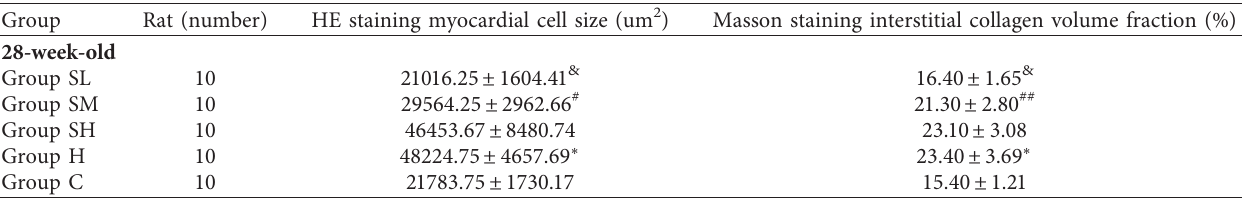
Table 2: Myocardial cell size and interstitial collagen volume fraction (M ± SD).